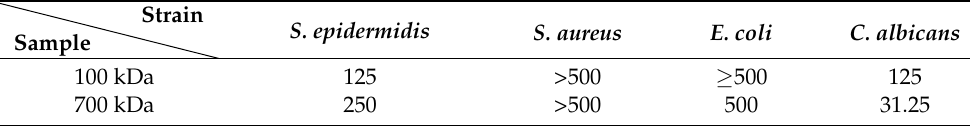
Table 3. Minimal inhibitory concentration of chitosans, µ